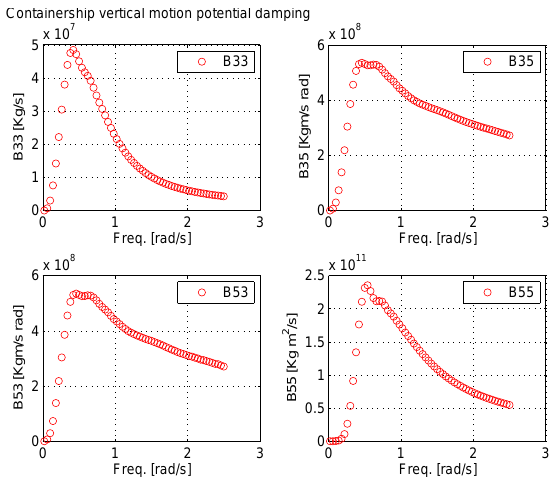
Figure 2: Potential damping computed by hydrody- namic